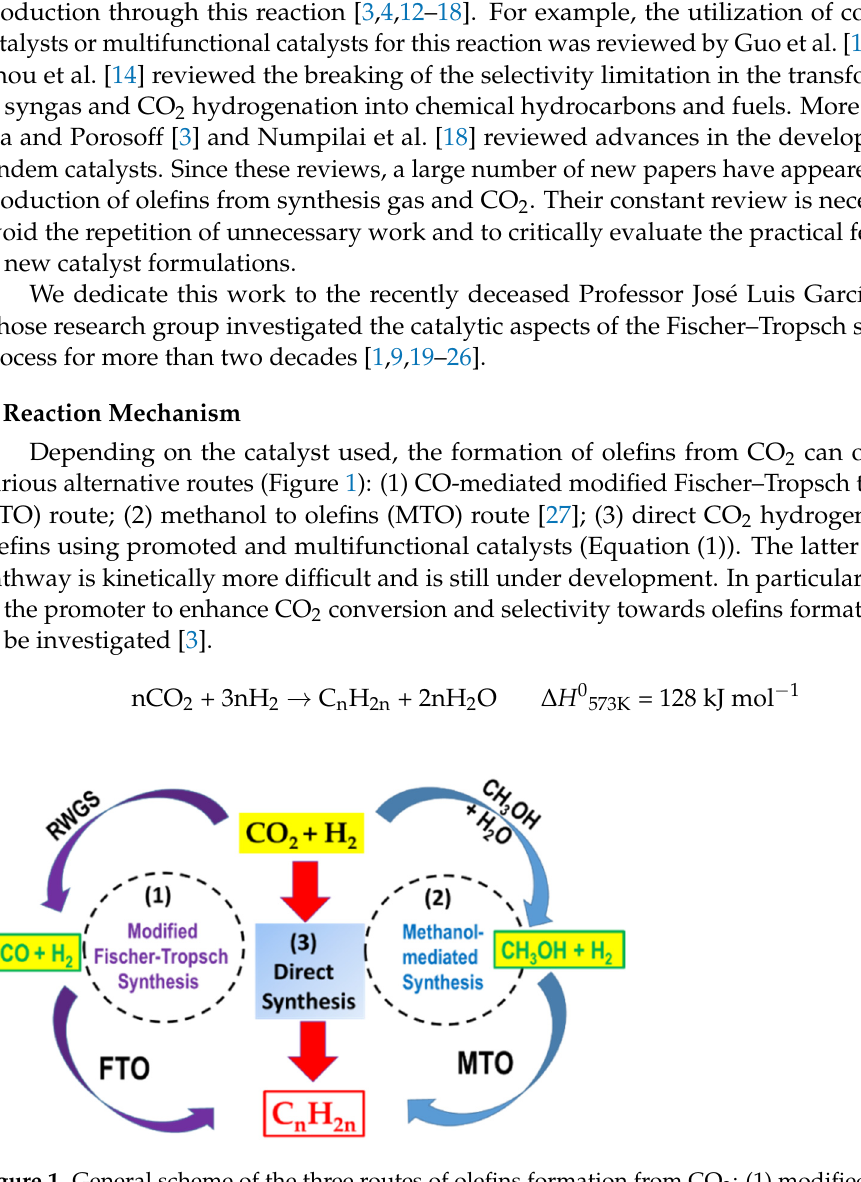
Figure 1. General scheme of the three routes of olefins formation from CO 2 : (1) modified Fischer– Tropsch to olefins (FTO) route; (2) methanol to olefins (MTO) route; (3) direct olefin formation over multifunctional, promoted catalysts.